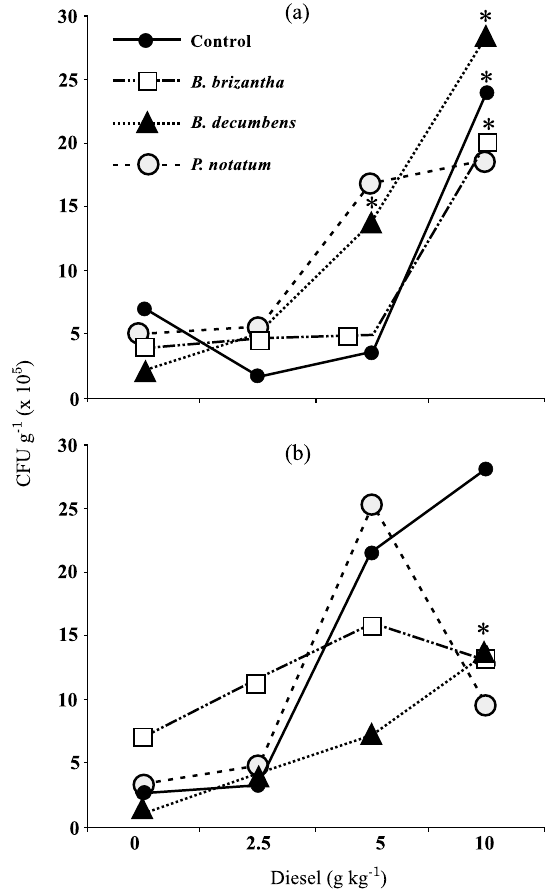
Figure 4. Number of bacterial colony-forming units (CFU) per gram of soil contaminated with different diesel concentrations, after 4 (a) and 10 weeks (b) of treatment. *: significant at 5 %, by Tukey´s LSD